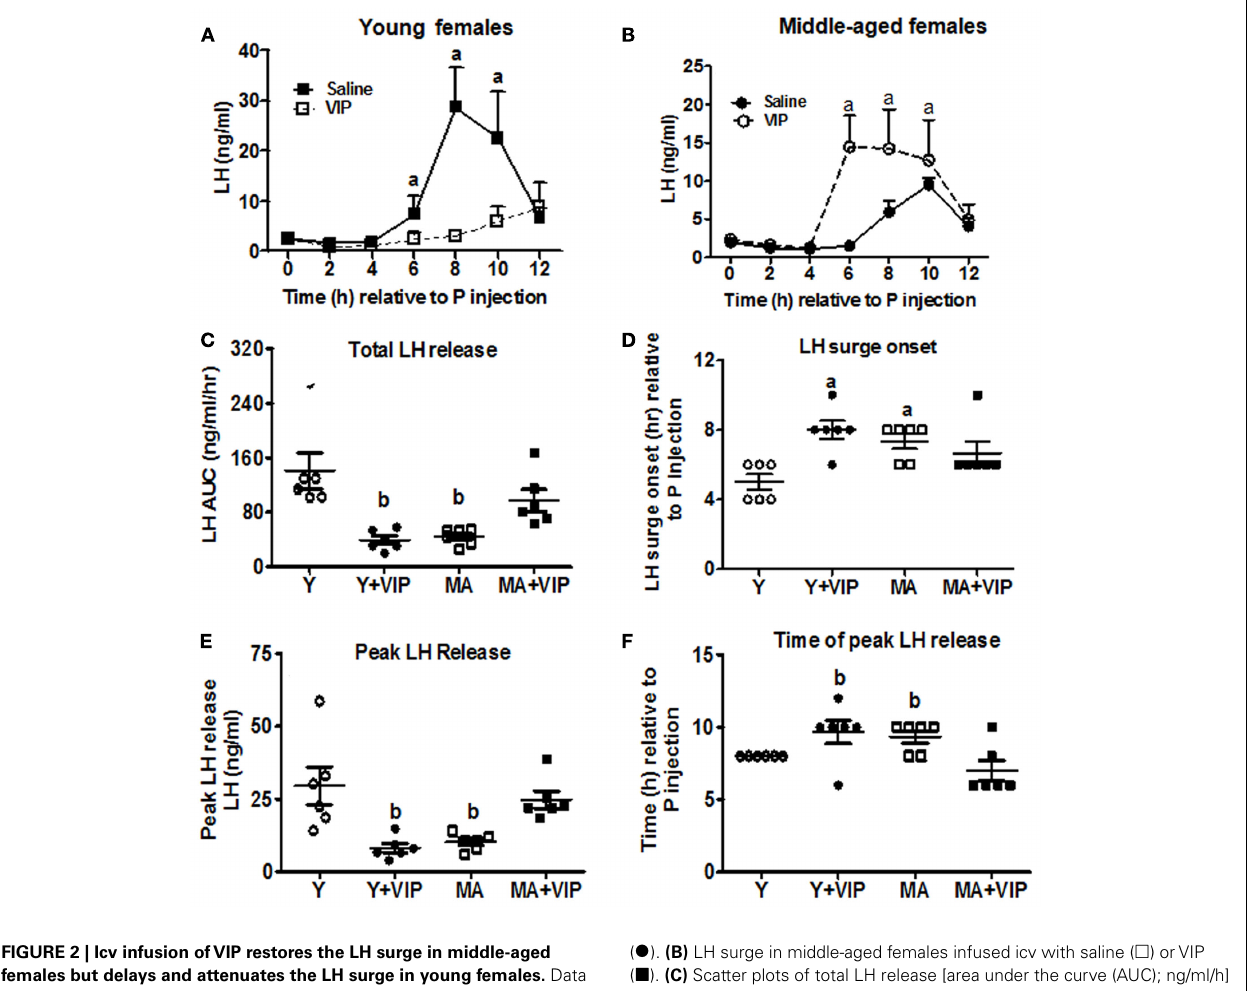
FIGURE 2 | Icv infusion ofVIP restores the LH surge in middle-aged females but delays and attenuates the LH surge in young females. Data are expressed as mean ± SEM. OVX young (Y; n = 6) and middle-aged (MA; n = 6) rats were primed with two daily doses of E (2 μ g) and one injection of P (500 μ g) on the day of serum collection and infused with saline (control) orVIP (6nmol) between 1300 and 1600h. Serial blood sampling started at the time of P injection and continued every 2h for 12h.To compare the effect ofVIP infusion on LH release in control females, we included the LH surge data for young and middle-aged, saline infused E + P-primed females shown in Figure 1 . (A) LH surge in young females infused icv with saline (